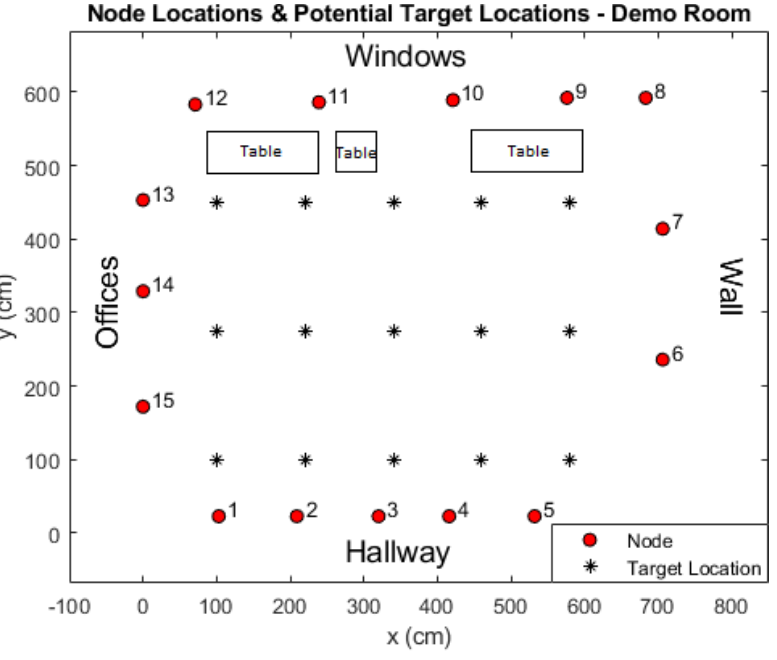
Figure 2. A schematic overview of the experimental